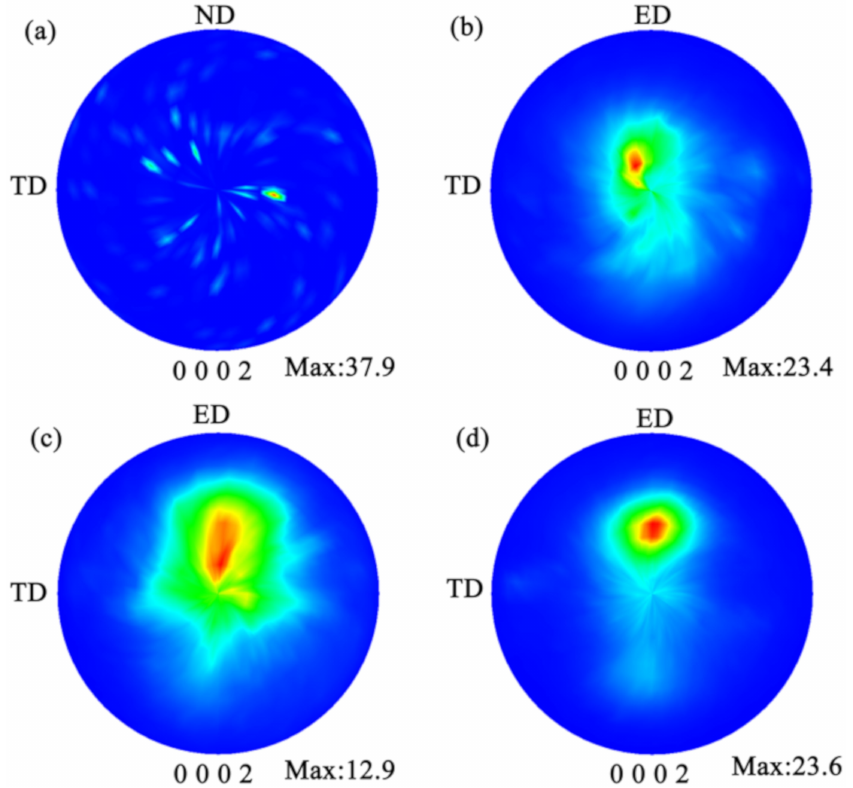
Figure 10. (0002) pole figure based on XRD results of ( a ) the homogenized alloy, ( b ) the alloy after 1 pass, ( c ) the alloy after 2 passes, and ( d ) the alloy after 3 passes of